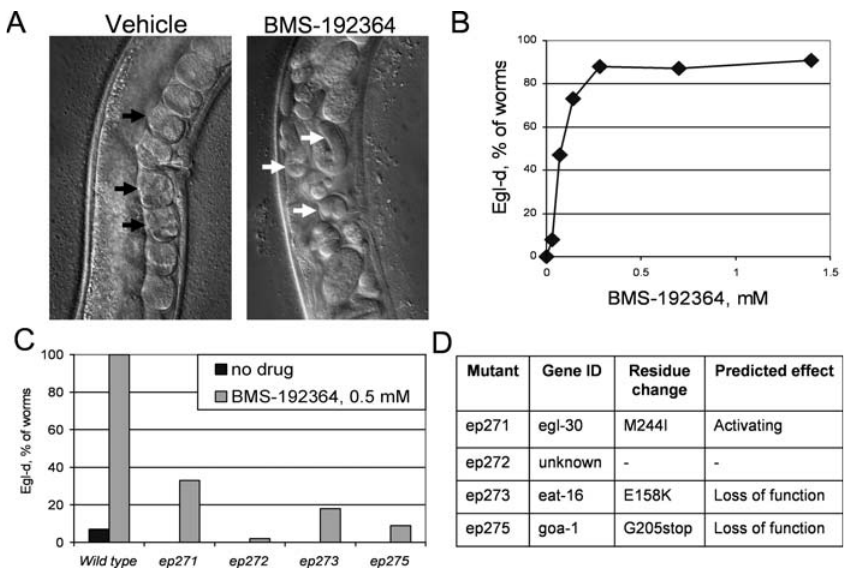
Figure 3. Effect of Small Molecules on Wild-Type and Mutant C. elegans (A) The gonad/vulval region of wild-type worms is shown. In the left panel, black arrows indicate the normal, organized array of early stage eggs. The right panel shows a worm treated with BMS-192364 at 0.3 mM. The white arrows indicate late stage eggs that have been retained in the gonad. (B) Dose-response curve for BMS-192364, showing effect on egg laying in C. elegans . The percentage of worms displaying an Egl-d phenotype was determined by counting the number of ‘‘ commas ’’ contained within the animal. (C) Quantification of the Egl-d phenotype in four C. elegans mutant strains— ep271, ep272, ep273, and ep275— that were identified in a screen for resistance to the small molecule. Black bars, no treatment. Grey bars, worms treated with BMS-192364 at 0.4 mM. (D) Table showing identity of the affected gene in C. elegans– resistant mutant strains, the amino acid changes, and predicted effect on protein function. DOI: 10.1371/journal.pgen.0020057.g003